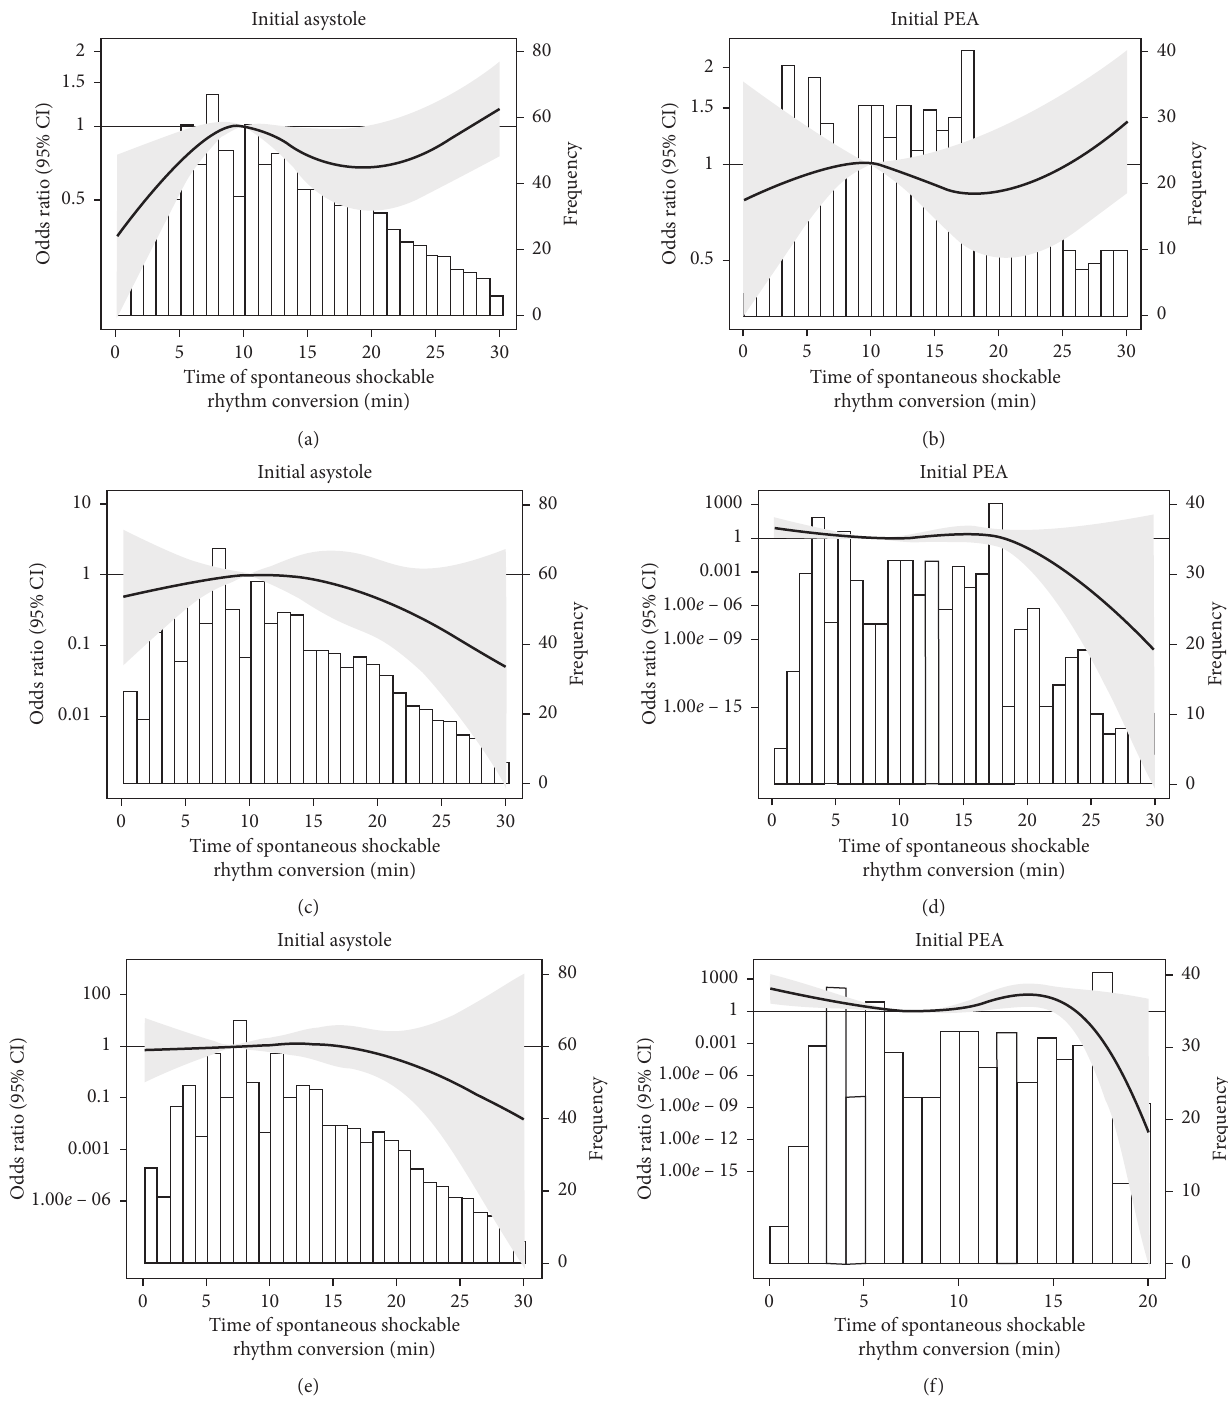
Figure 2: Adjusted odds ratios and 95% confidence intervals comparing shockable rhythm conversion and nonshockable rhythm conversion for prehospital return of spontaneous circulation, survival to hospital discharge, and favorable functional outcome at hospital discharge by time of rhythm conversion in initial heart rhythm in the ROC Cardiac Epidemiologic Registry (version 3). (a) Adjusted odds ratios and 95% confidence intervals for prehospital return of spontaneous circulation in OHCA patients with initial asystole or PEA. (b) Adjusted odds ratios and 95% confidence intervals for survival to hospital discharge in OHCA patients with initial asystole or PEA. (c) Adjusted odds ratios and 95% confidence intervals for favorable functional outcome at hospital discharge in OHCA patients with initial asystole or PEA. OHCA, out-of-hospital cardiac arrest; PEA, pulseless electrical activity; CI, confidence